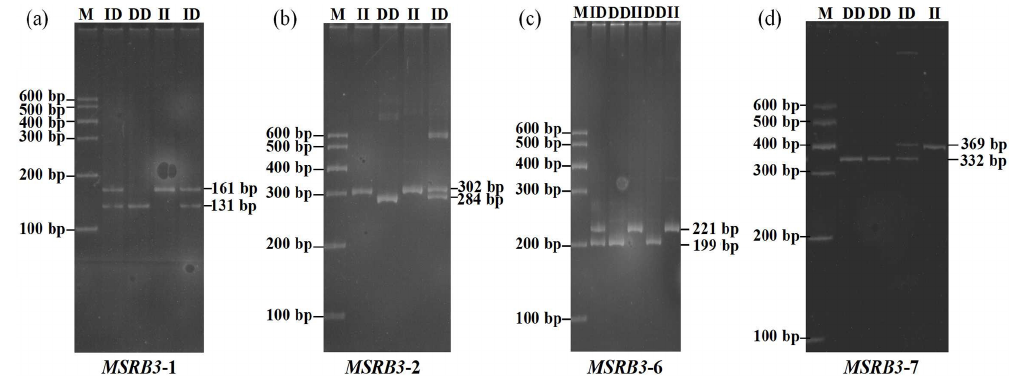
Figure 1. The agarose gel electrophoresis patterns of four indel loci in cattle MSRB3 gene. Table 2. Genotypes, allele and population genetic information of four indel loci in MSRB3